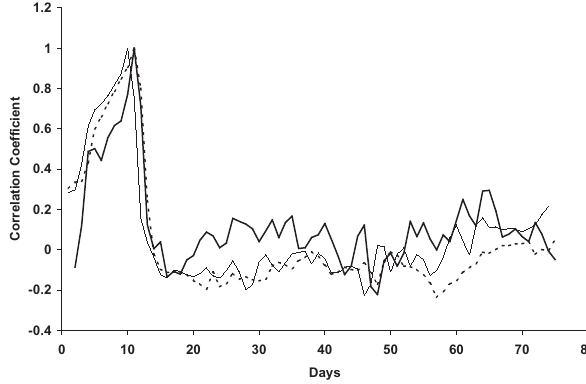
Fig. 12. Correlation between nitrate at 65m and nitrate in any box, for an ensembles size of 50 ( ), 90 ( ) and 150 (- - -) members. Data was assimilated once after 32